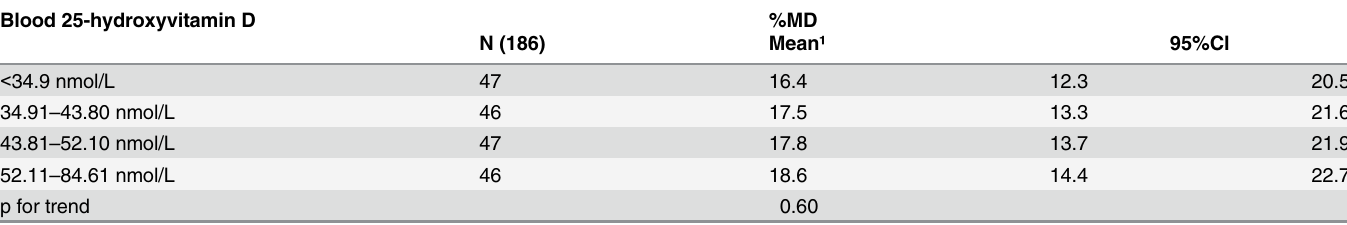
Table 6. Blood 25-hydroxyvitamin D and percent mammographic density (%MD). Blood 25-hydroxyvitamin